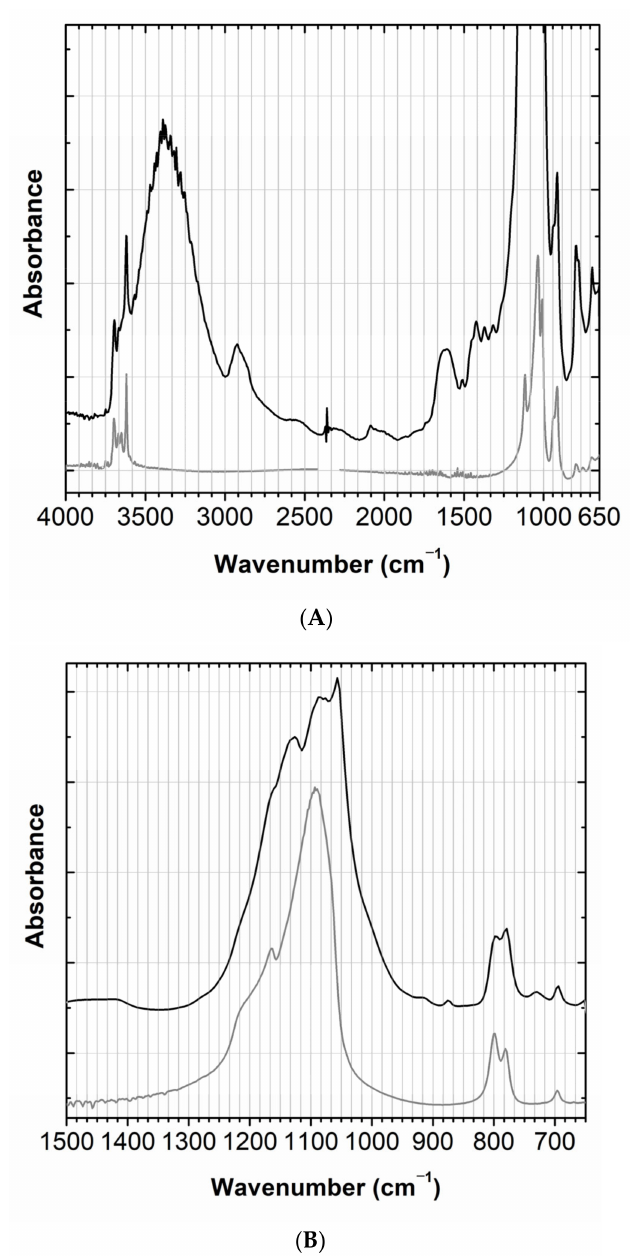
Figure 4. ( A ) Infrared spectra of papier-m â ch é (black) compared with a kaolin reference (grey) . ( B ) Infrared spectrum of papier-m â ch é (black) compared with a quartz reference (grey), in the 1500–650 cm − 1 region; full spectra in Appendix B, Figure